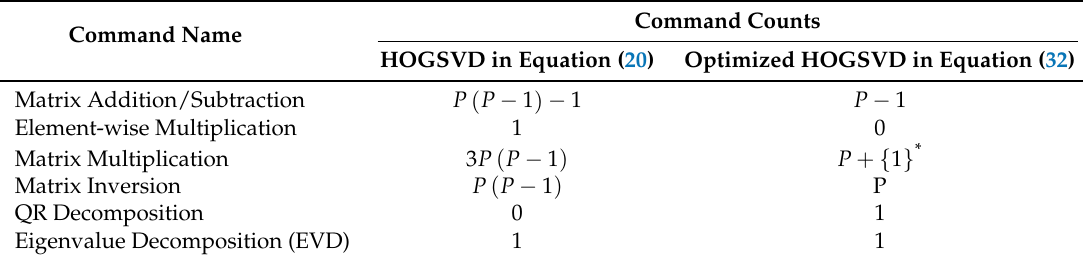
Table 1. Command used in HOGSVD.